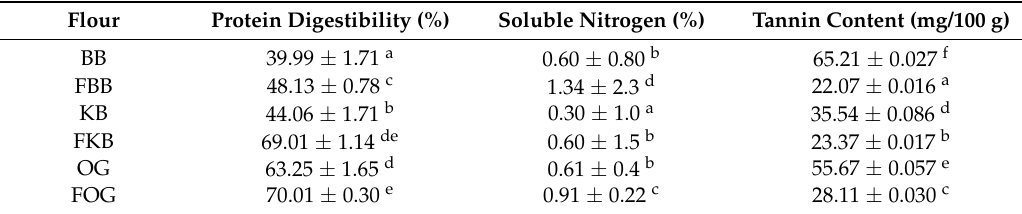
Table 3. Protein digestibility, soluble nitrogen and tannin content.